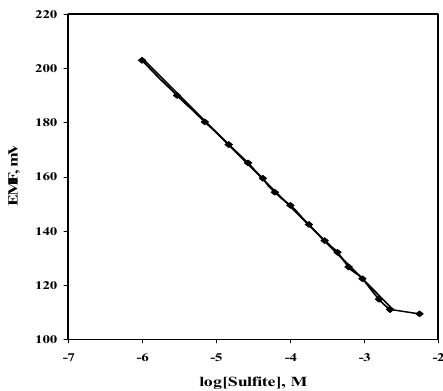
Figure 3. Calibration plot of sulfite ion using [CoPC / TDMA + / o -NPOE] PVC membrane-based sulfite